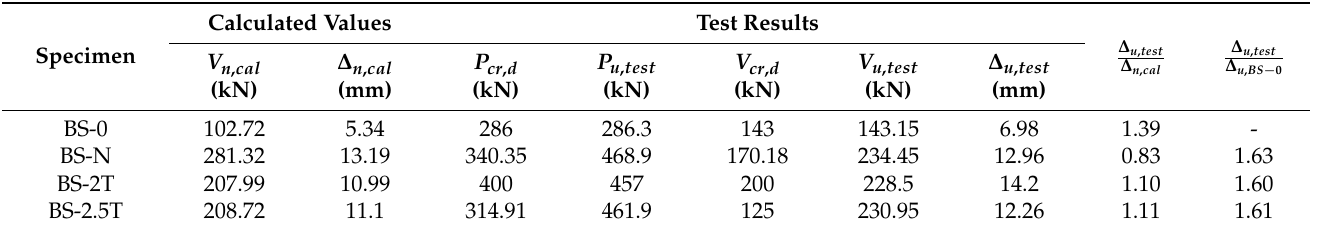
Table 4. Test results.